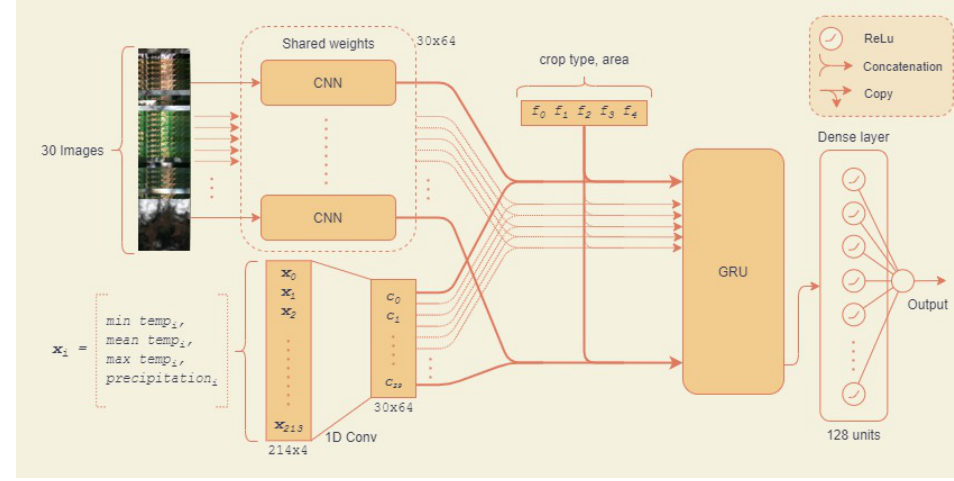
Figure 8. Novel approach 2: architecture of Hybrid CNN model.